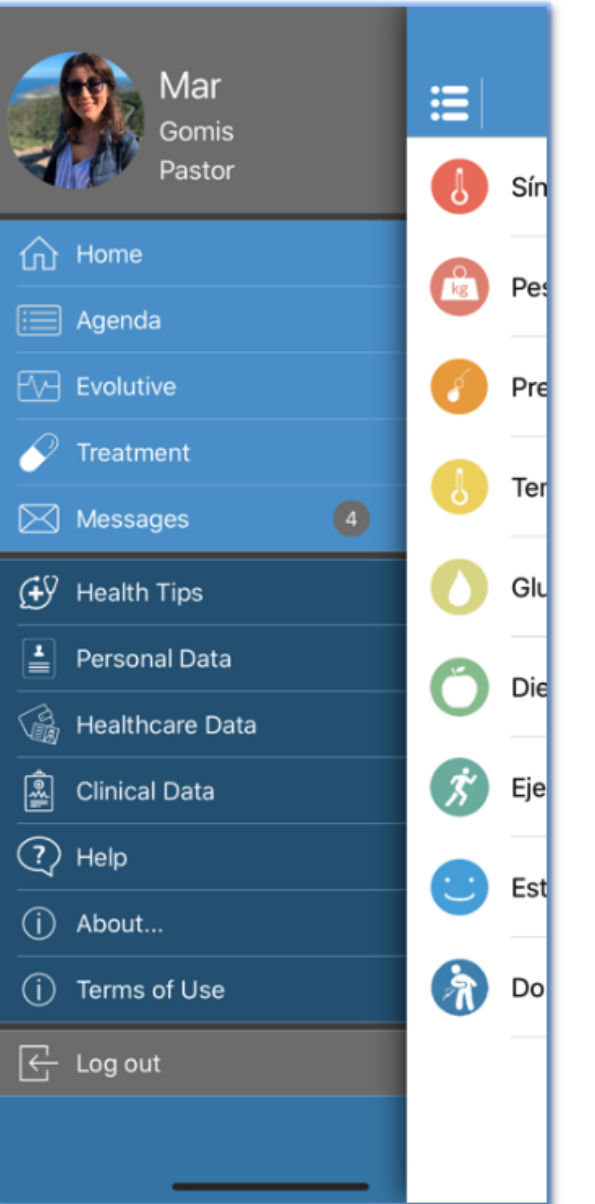
Figure 1. The mHeart system menu, displaying the different app modules: Treatment, Agenda, Self-control, Symptoms, Messaging, Health Education and Advice, Personal and Clinical